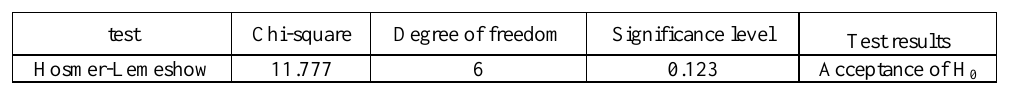
Table 4 Hosmer-Lemeshow